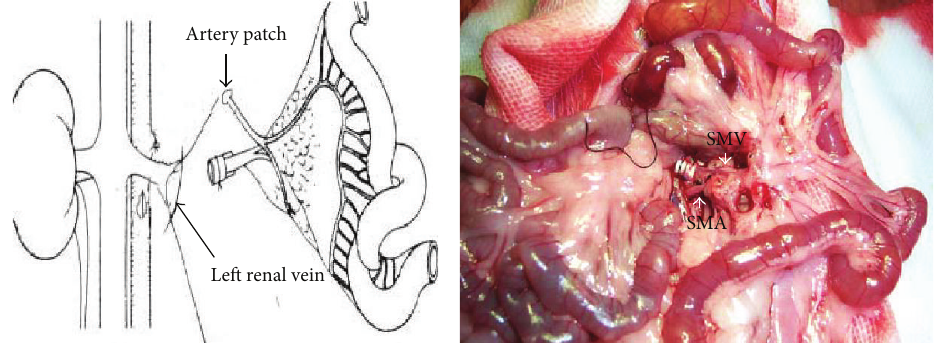
Figure 1: Vessel reconstruction : donor graft’s cuffed portal vein is inserted into left renal vein of the recipient and an end to side anastomosis is performed between SMA and the abdominal aorta. The right picture shows a typical graft 20 seconds after artery anastomosis and vein insertion and demonstrates good blood circulation in the